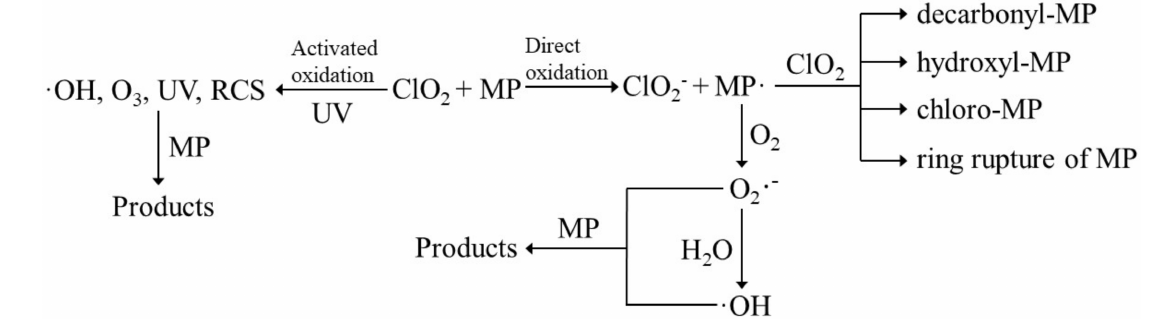
Figure 1. The degradation pathway of direct and activated ClO 2 oxidation for